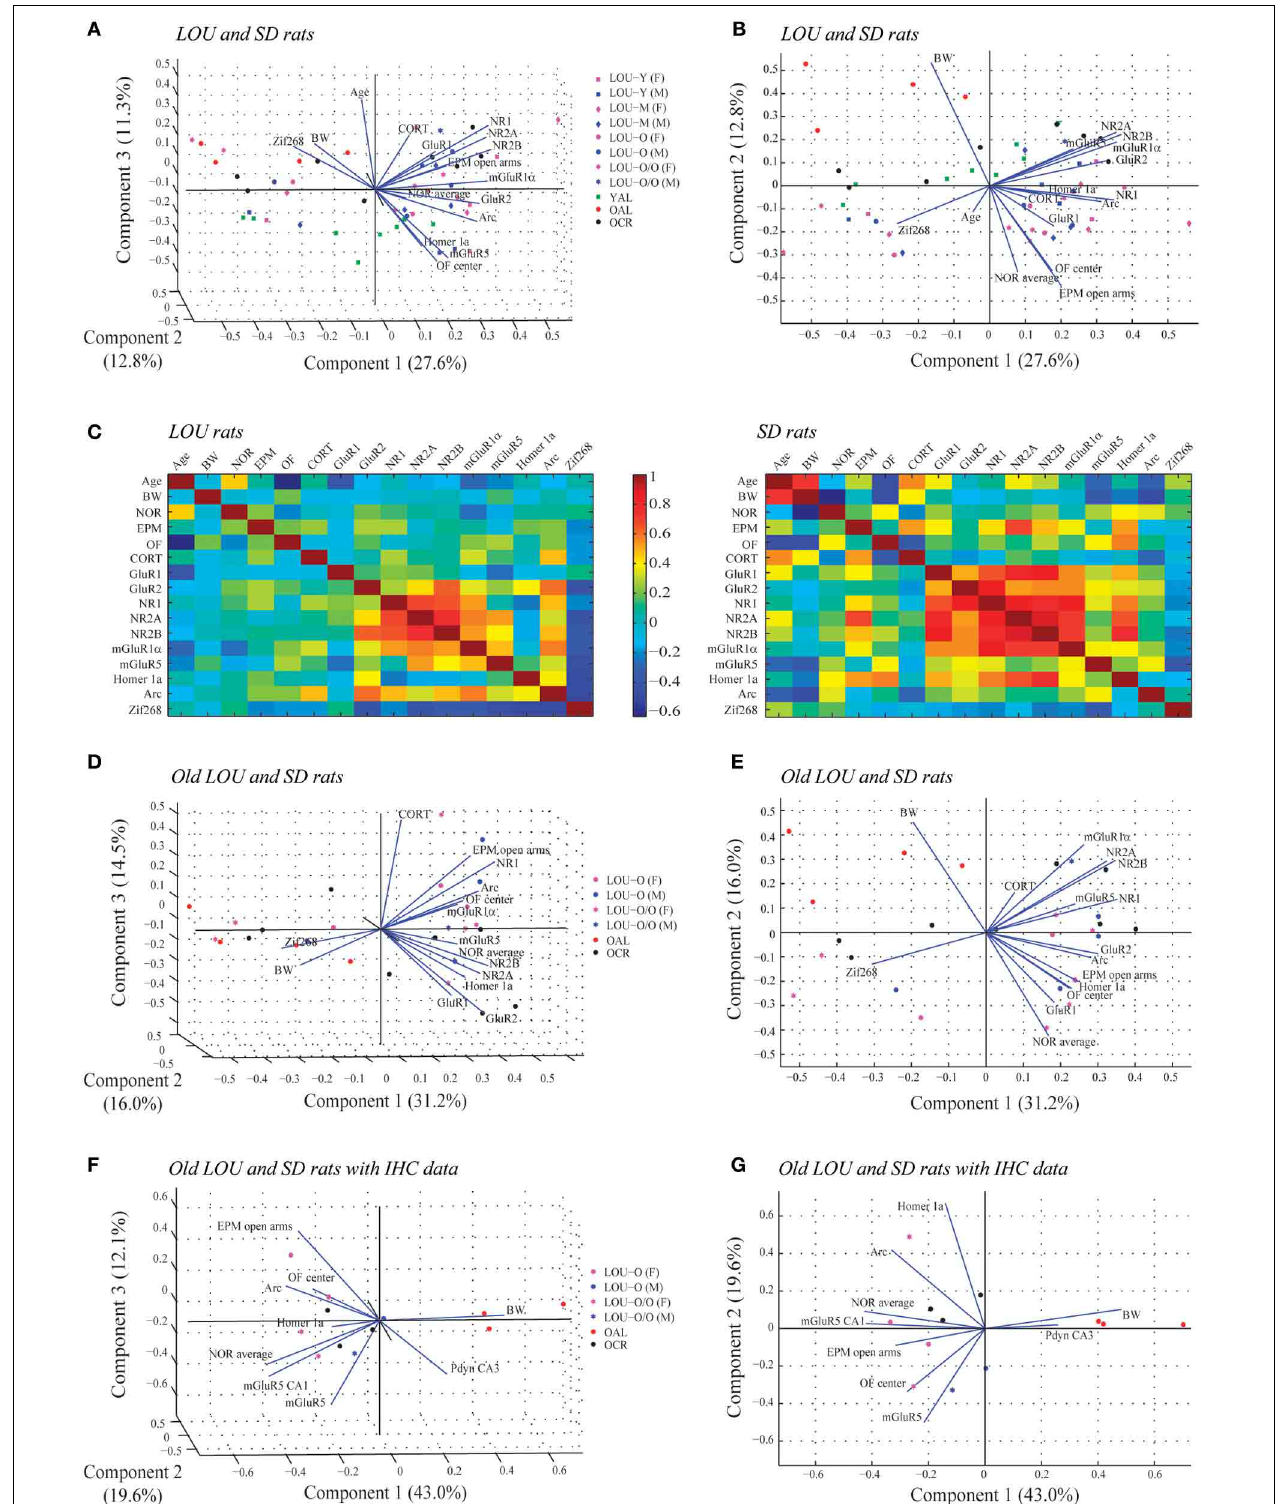
FIGURE 9 | Associations between physiological parameters, cognition, anxious behaviors, glutamatergic signaling, and stress-related markers in aging LOU and SD rats. (A) Biplot of the principal component coefficients and scores (first three components) of all LOU and SD rats data sets for 16